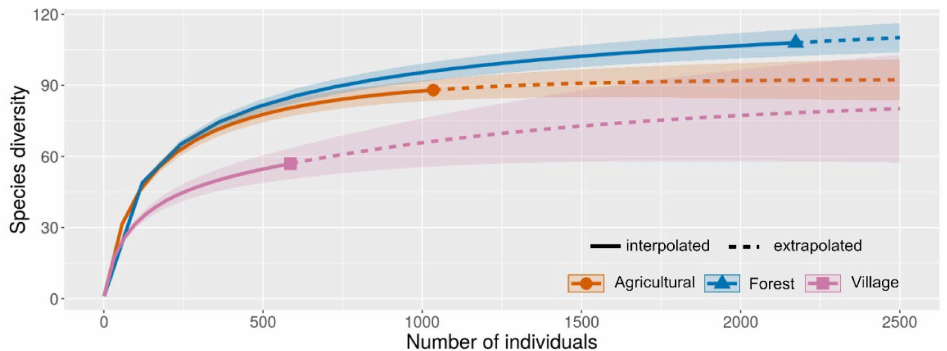
Figure 9. Diversity comparisons for mosquitoes in forest, agriculture, and village areas. The shaded area represents 95% confidence intervals. Solid line = observed species (interpolation); dash line = ex- trapolation species richness. Sample coverage of the reference sample for each area: forest = 0.993; agriculture = 0.990, and village = 0.975. q = 0, species richness with bootstrap of 1000.